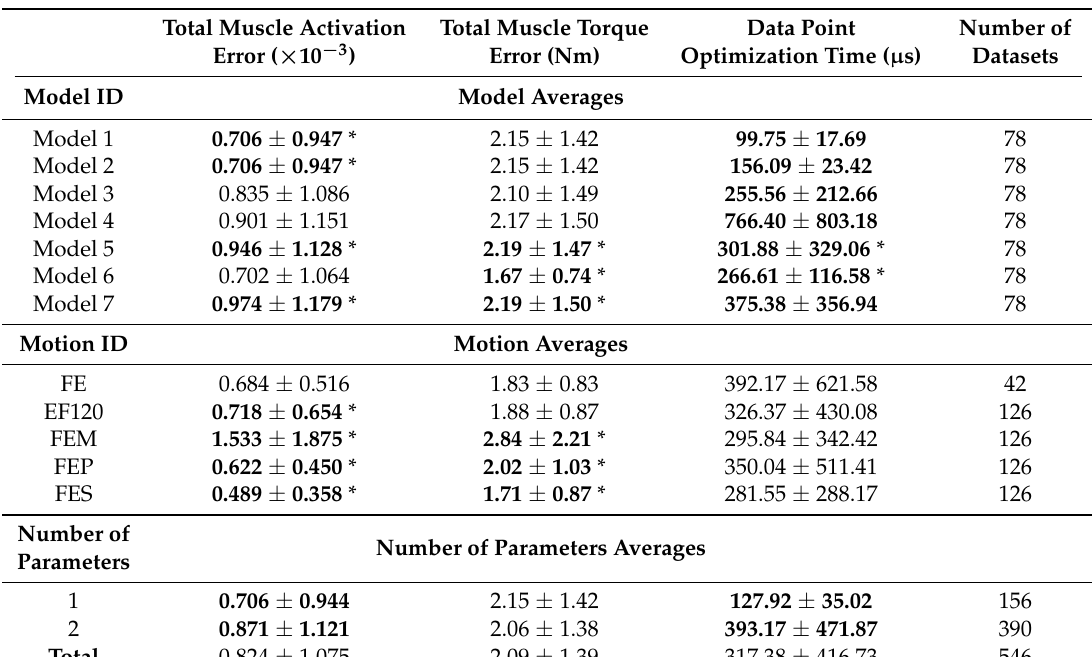
Table 5. Comparison of the total muscle activation error, total muscle torque error and data point optimization time